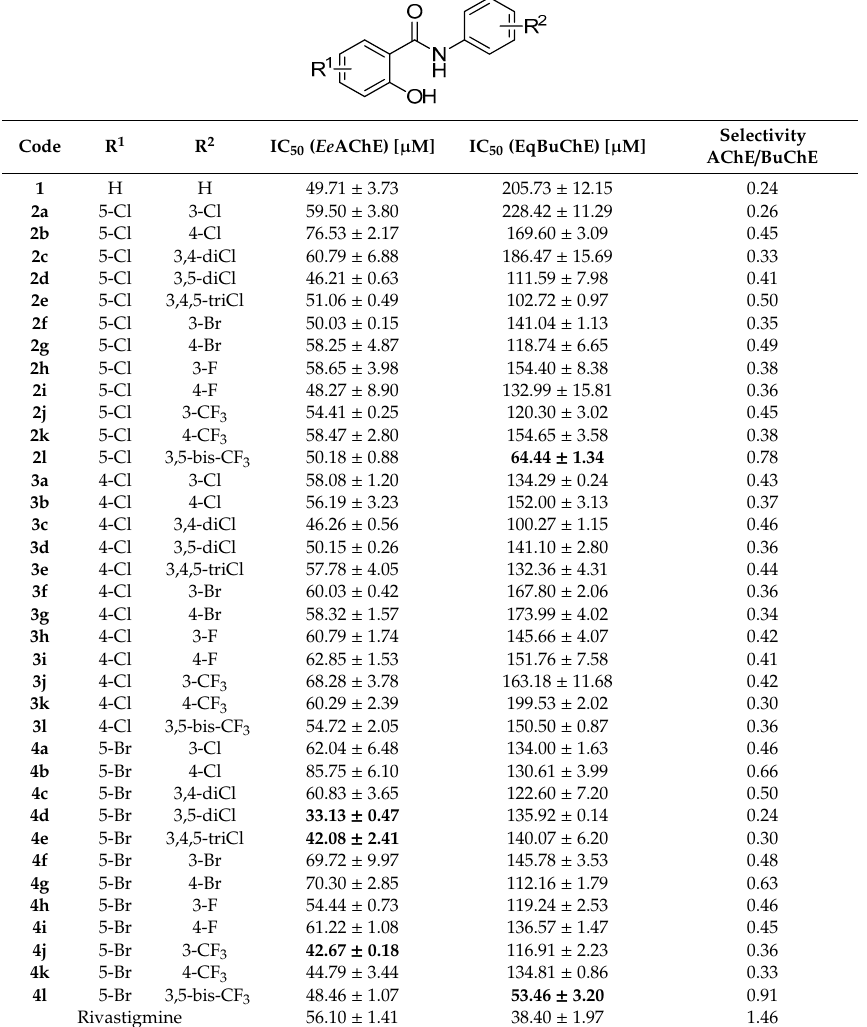
Table1. Structuresof2-hydroxybenzamidesandIC 50 foracetylcholinesteraseandbutyrylcholinesterase. Table 1. Structures of 2-hydroxybenzamides and IC